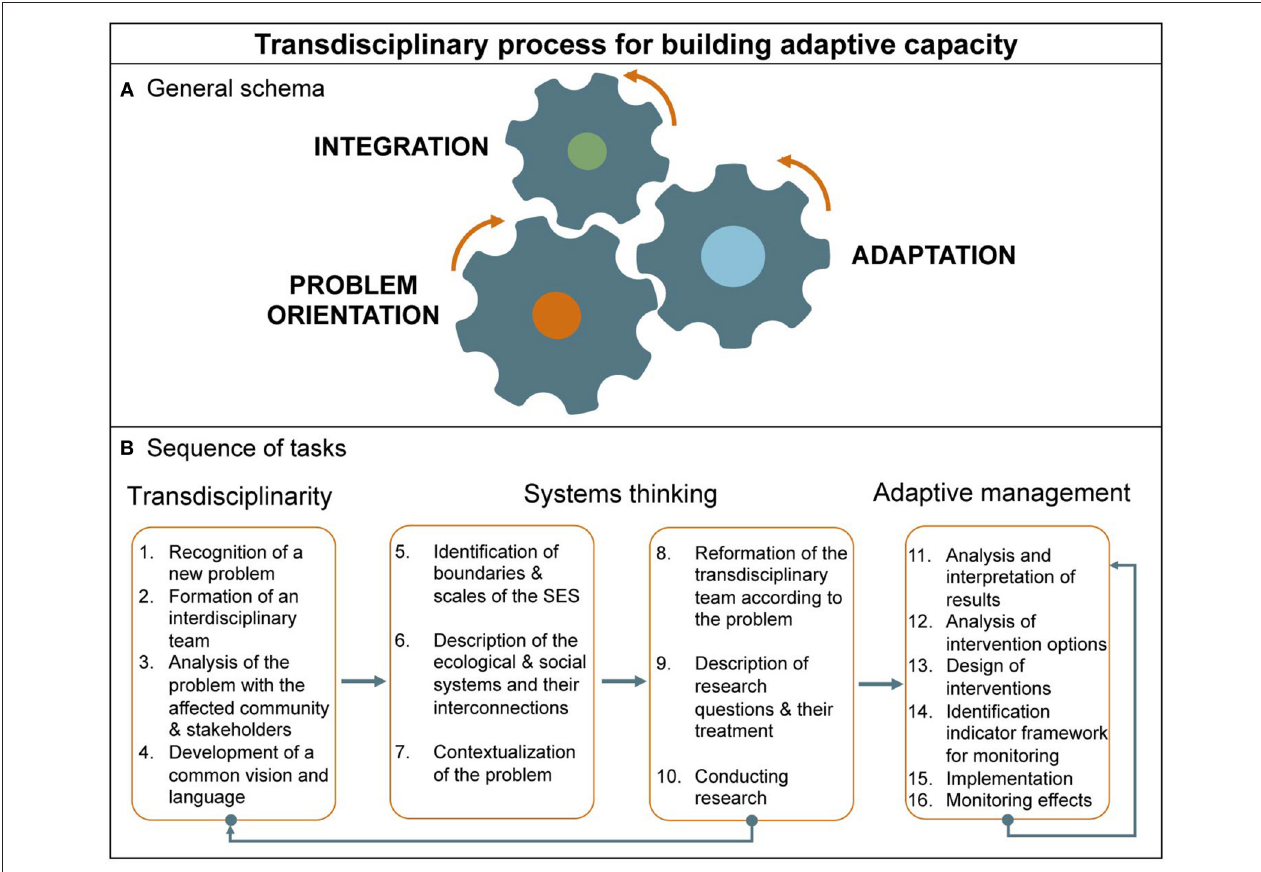
FIGURE 4 | Transdisciplinary process for building adaptive capacity. (A) Transdisciplinarity can be envisioned as a process involving three mutually reinforcing, and overlapping activities: problem orientation, integration and adaptation (as defined in the text). (B) This process can be further broken down into a sequence of specific actions representing a protocol against progress including conformance to One Health as a transdisciplinary, ecosystem approach could be measured, when combined with the criteria described in Table 1 [adapted from Richter et al. (53)].